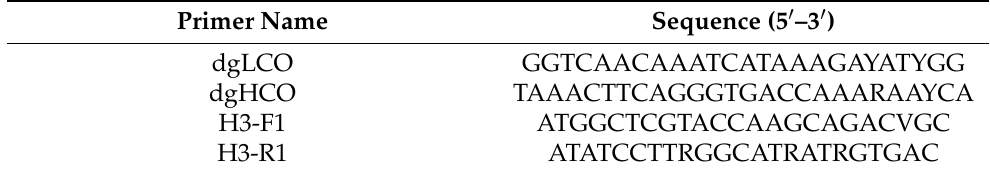
Table 1. Mitochondrial gene amplification employs general and highly specialized